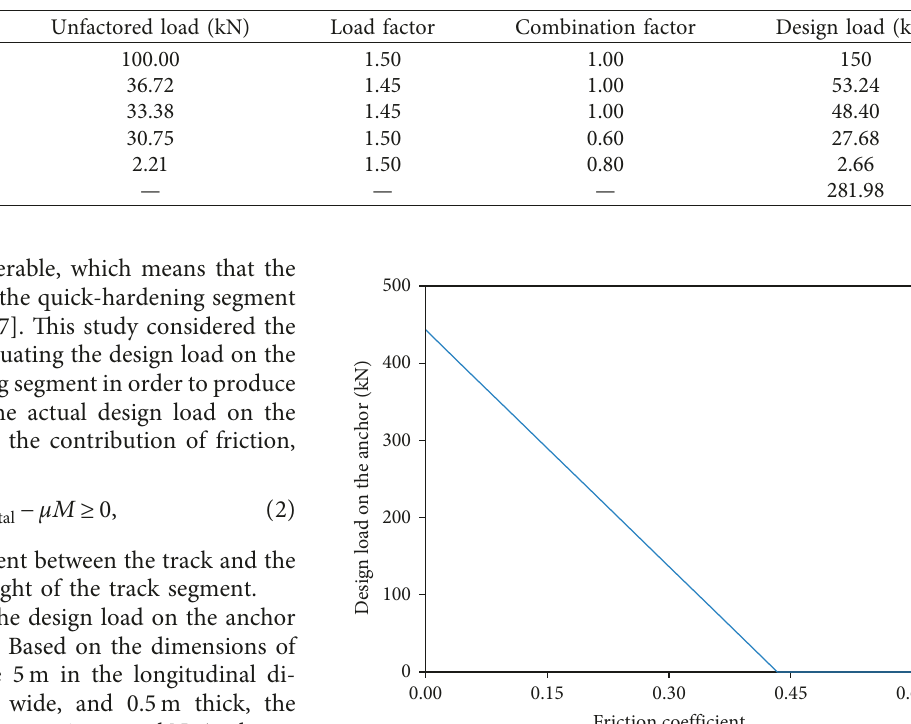
Table 2: Transverse design load ( P t ) on a quick-hardening track segment.